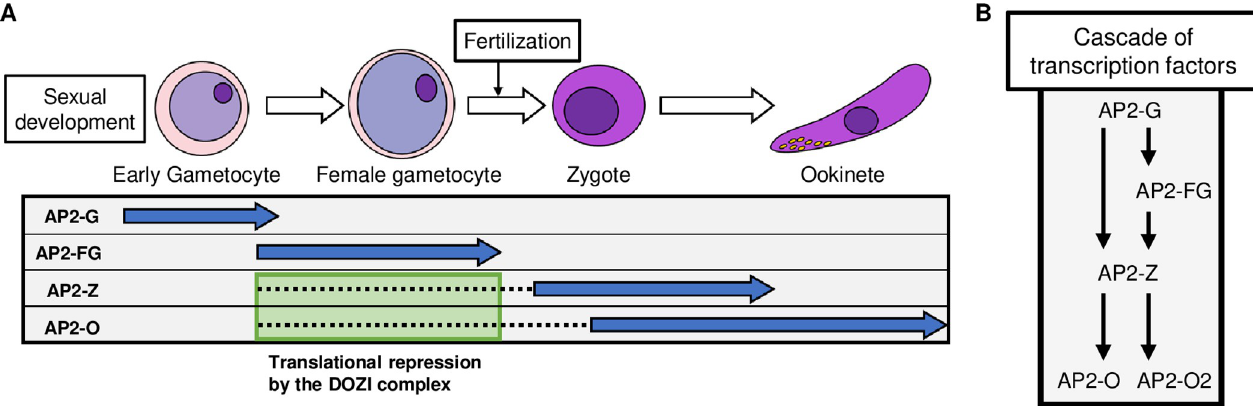
Fig 10. Cascade of transcription factors during the sexual development of Plasmodium . (A) Schematic illustration of the sequential expression of sexual transcription factors: AP2-G, AP2-FG, AP2-Z, and AP2-O. Blue arrows indicate a period of protein expression and dashed lines indicate a period of translational repression. (B) Schematic illustration showing the hierarchical relationship of sexual transcription factors during Plasmodium sexual development.